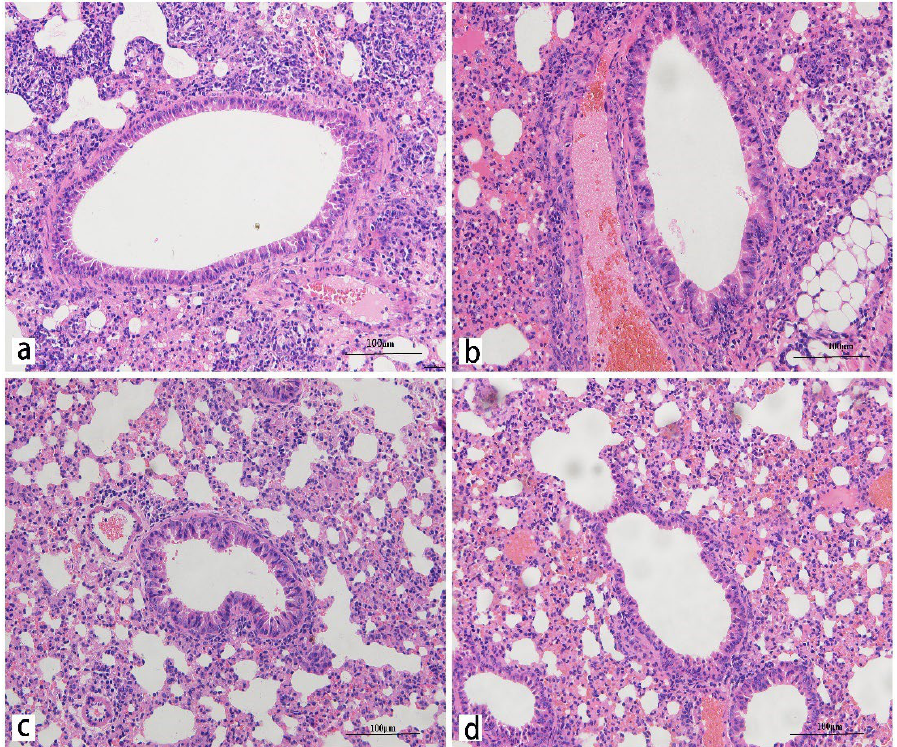
Figure 5. Representative HE-stained sections of lung from mice on days 2( a ), 5( b ), 9( c ), and 14( d ) after infection; i.v. infected with M. gypseum (4 × 10 6 CFU/mL). Lung injury was mainly featured with destroyed alveoli, decreased number of alveoli, thickened alveoli septum and significant in- flammatory cell infiltration; and exudation of fibrin was found in the alveolar on days 2( a ) and 5( b ) after infection. Scale bars, 100